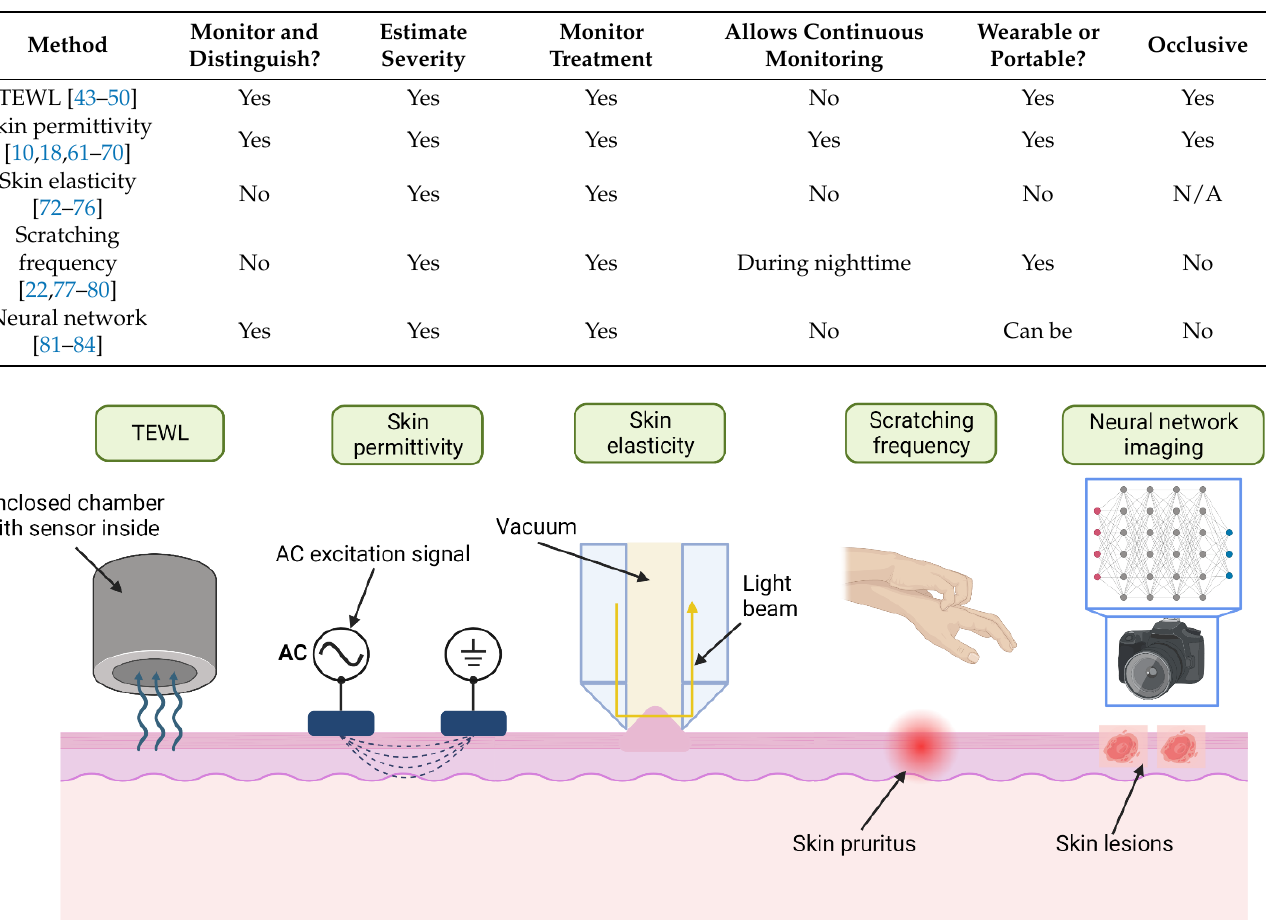
Figure 9. Illustration of different non-invasive telemedical methods for monitoring AD in vivo. The respective measurand parameters are presented on the top of each method’s illustration. The TEWL method features an enclosed chamber with a relative humidity sensor inside so that water vapors from the skin affect its reading. The skin permittivity sensor consists of 2 or more electrodes in contact with the skin of which one is a signal source and the other one is a signal pathway (ground) to establish a scattered electric field through the skin. The skin elasticity sensor uses negative pressure to suction parts of the skin and emit light through it to test the skin’s properties. The scratching frequency sensor detects when a person is scratching their AD lesions. The neural network imaging system uses a camera to distinguish lesions of AD from other similar conditions such as melanoma, skin burn, and